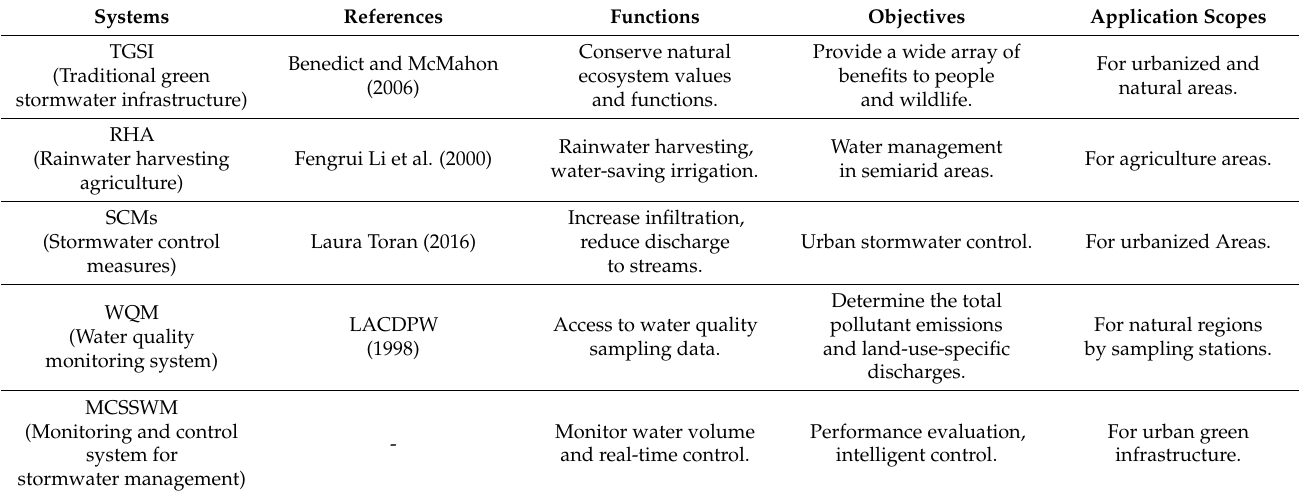
Table 2. Comparison of similar systems with